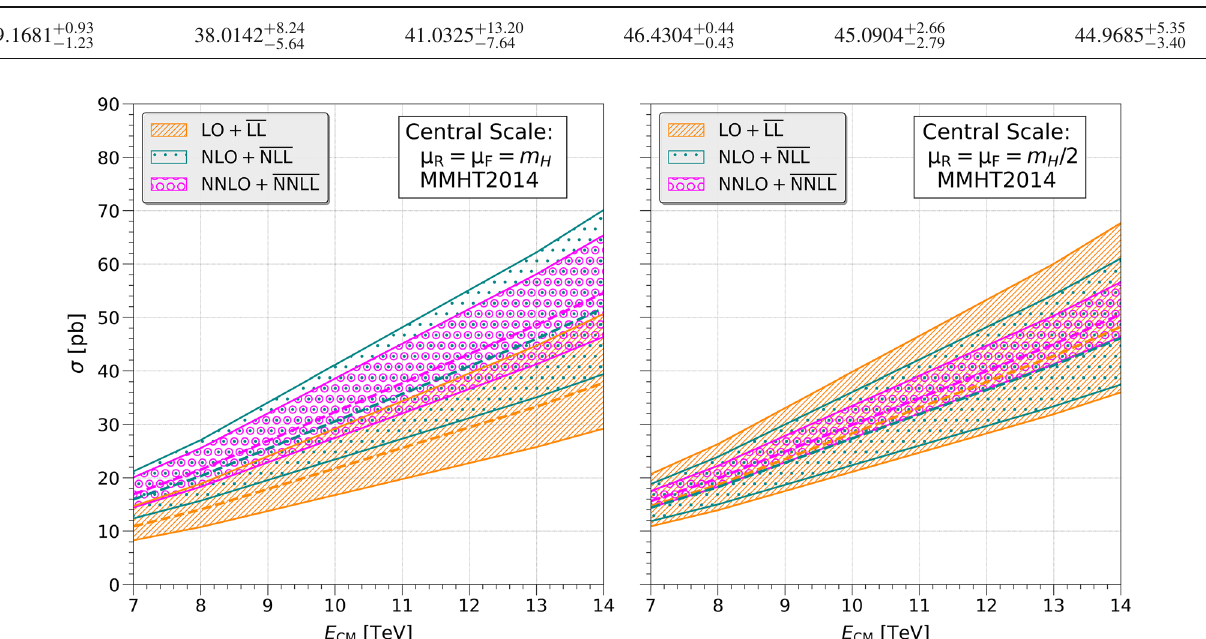
= μ = m μ = μ = m / 2 fortheleftandtherightpanel μ R F H and R F H respectively. The dotted line represents the value of the cross section at the central